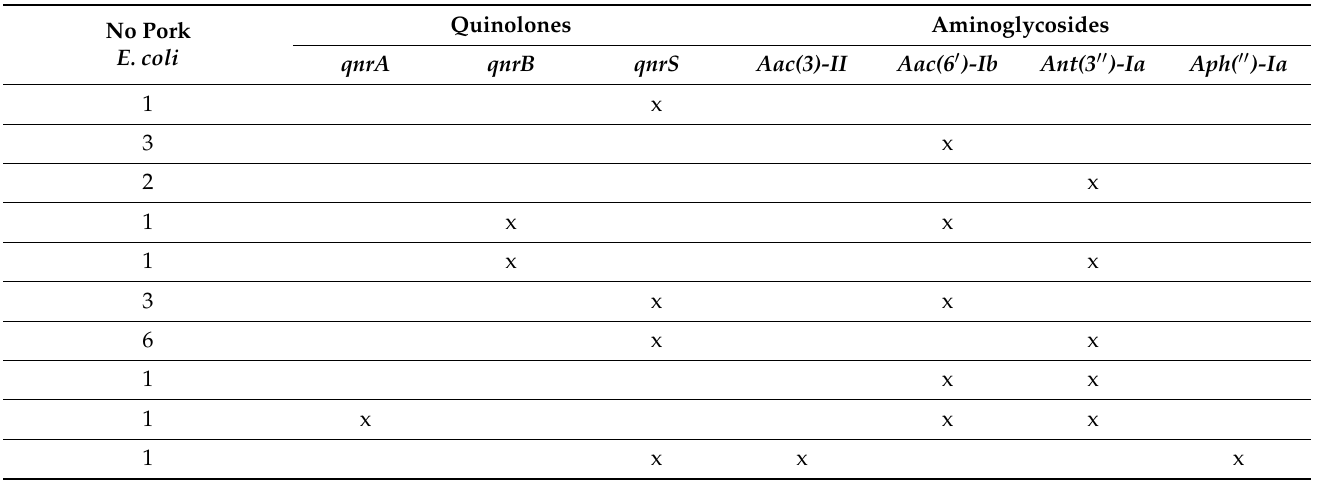
Table 3. Plasmid-mediated genes co-presence in E. coli isolated from pork and wild boar